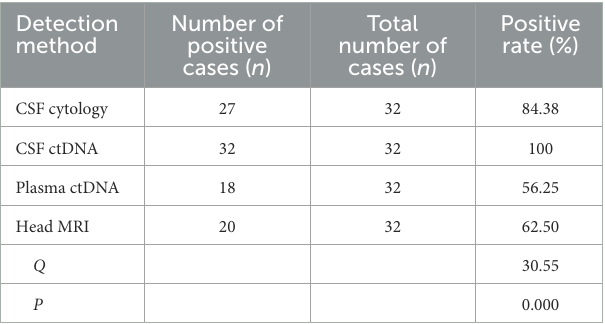
TABLE 3 Comparison of positive rate of CSF cytology, CSF ctDNA, plasma ctDNA and head MRI of 32 patients with